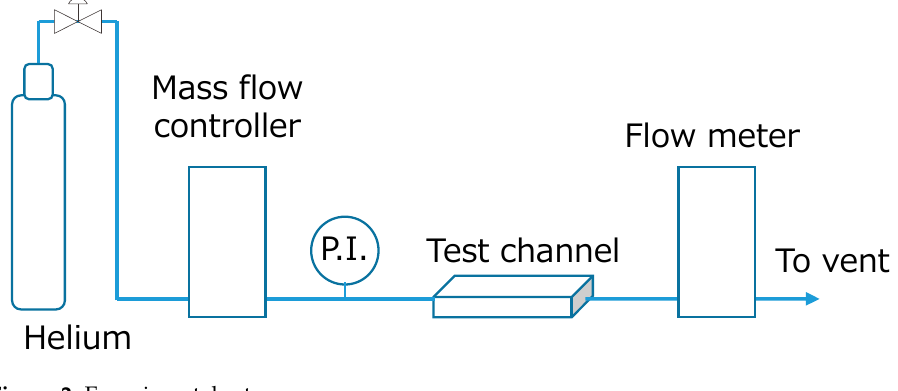
Figure 2. Experimental setup.